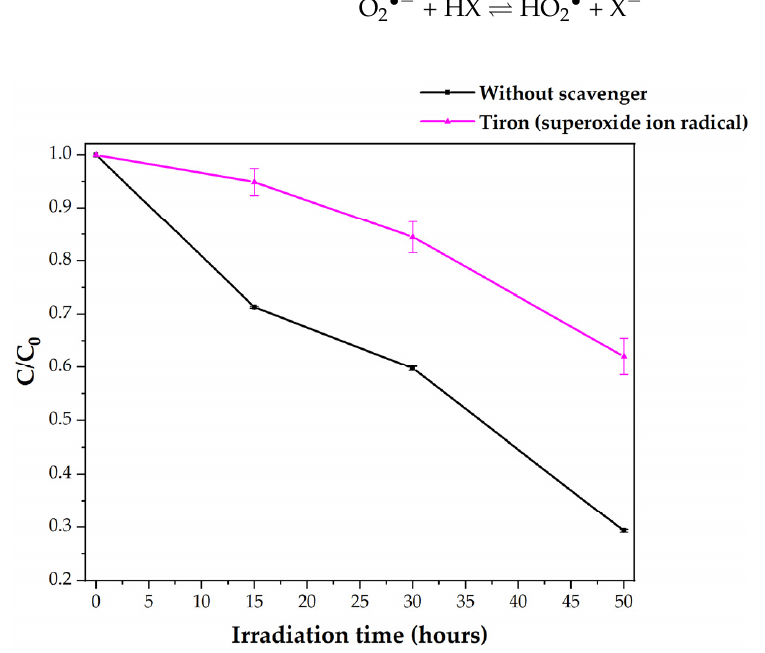
Figure 6. Visible-light photocatalytic degradation of HDPE MPs by C,N-TiO 2 in the absence and presence of Tiron as O 2 ●− scavenger.